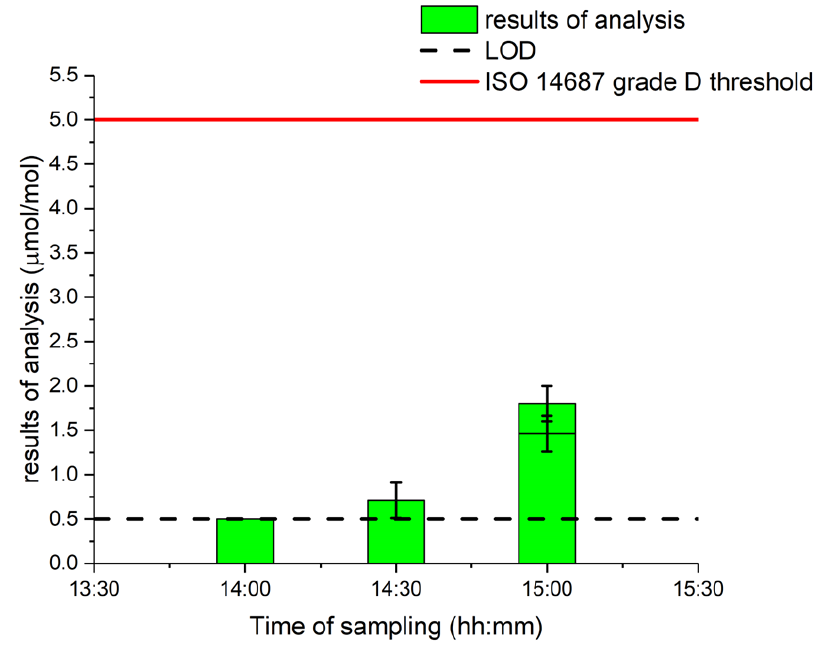
Figure 3. Liquid hydrogen gas water measurements in order of sampling.